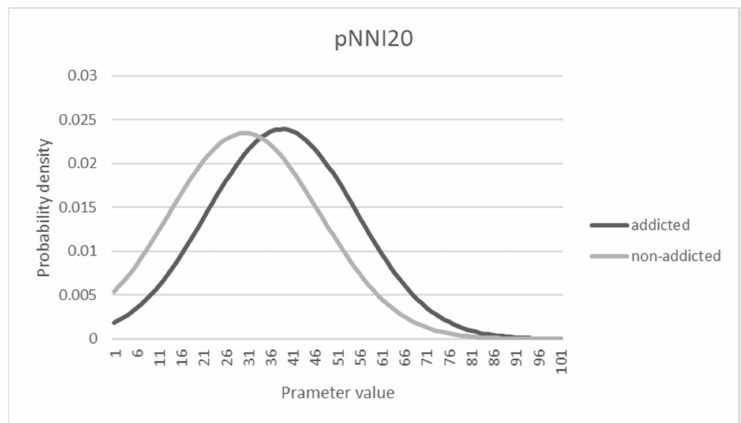
Figure 7. Probability density distribution of pNNI20 parameter.